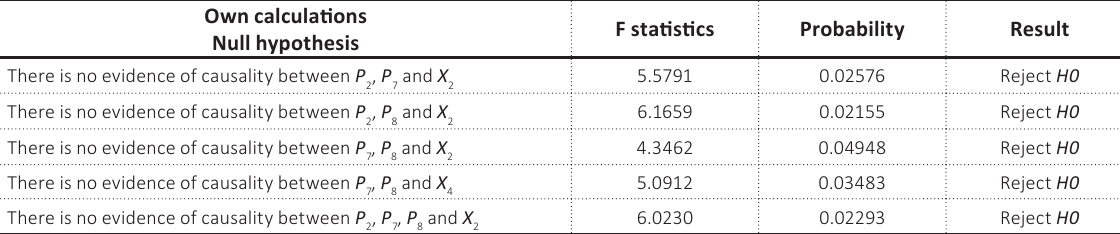
Source: Own calculations.